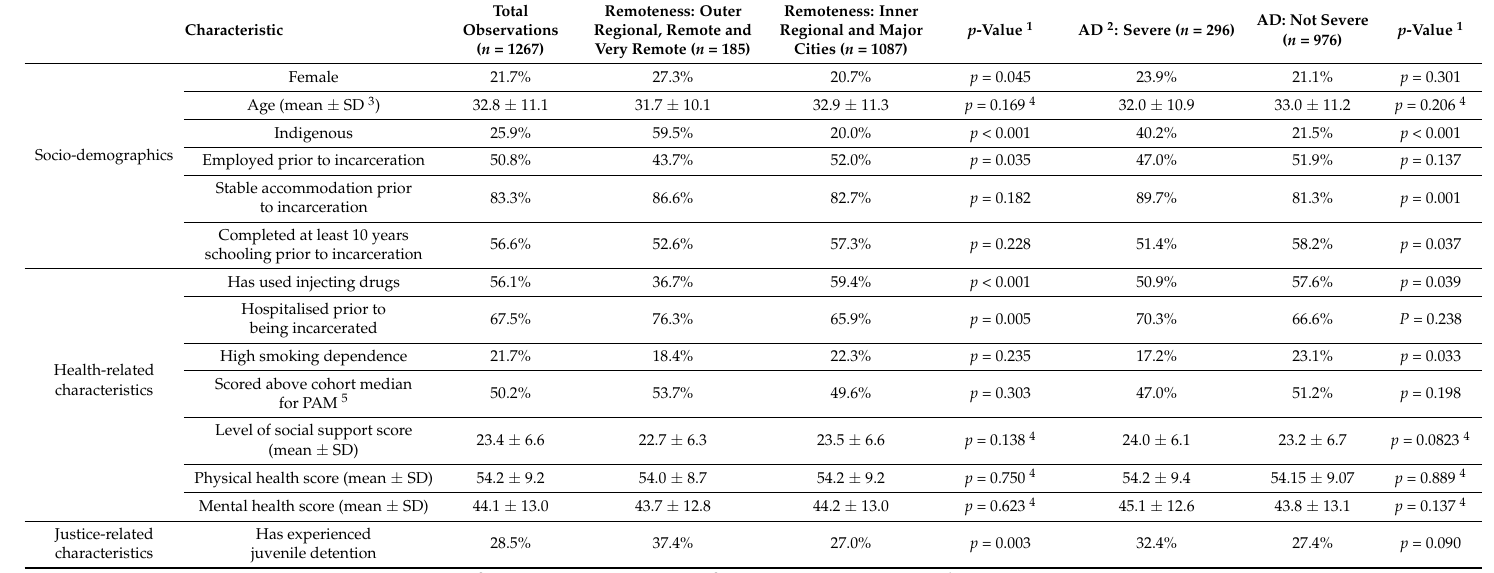
Table 1. Characteristics of the sample at baseline, according to remoteness and area disadvantage.